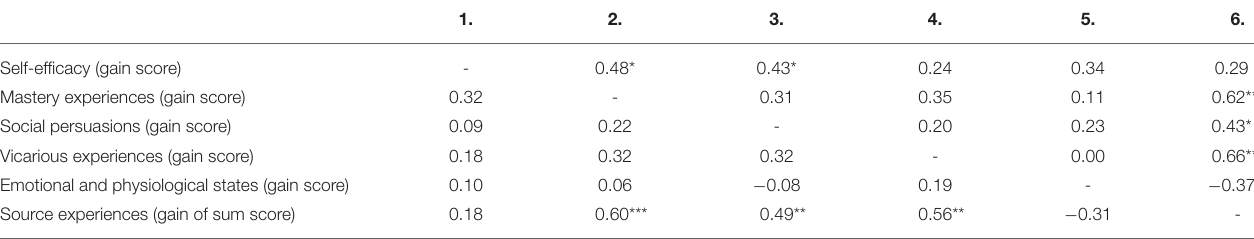
TABLE 5 | Spearman’s rank-order correlation coefficient between gain scores in source experiences and in self-efficacy among SKILL-group and SE-group (RQ2).